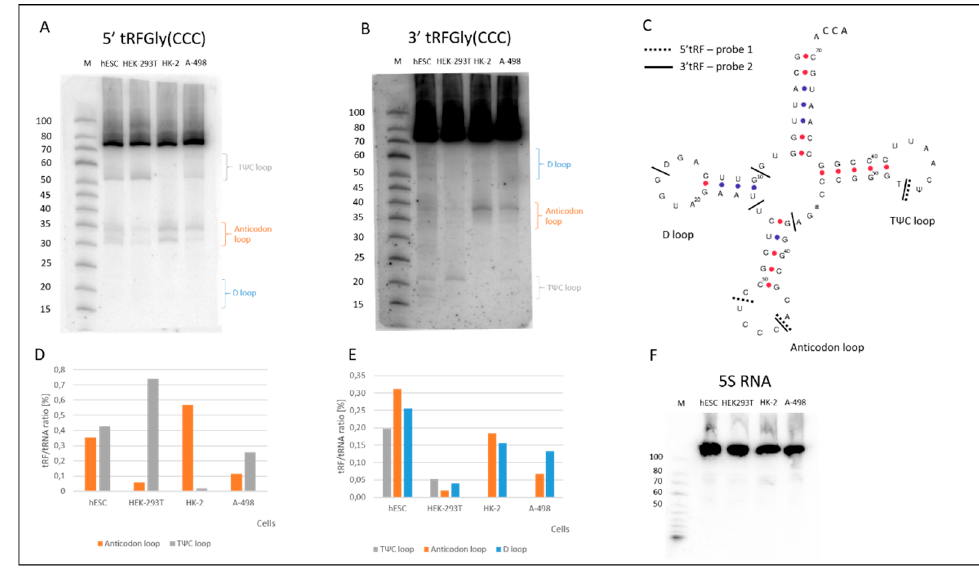
Figure 3. Characterization of the tRNAGly(CCC)-derived fragments. Northern blot ( A ) 5 ′ and ( B ) 3 ′ tRF detection with the use of two 32 P labelled probes 1 and 2 respectively (Table S1). ( C ) Secondary structure of human tRNAGly(CCC), with marked 5 ′ (---) and 3 ′ ( ꟷ ) cleavage sites. The locations of some of the modified D (dihydrouridine), T (ribothymidine) and Ψ (pseudouridine) nucleotides are marked in the tRNA structure. The loops in the tRNA structure have been named after these modifications. ( D , E ) The efficiency of the tRNAGly(CCC) cleavage in loops of the analyzed renal cells. ( F ) Loading control with a hybridization probe, which matches 5S rRNA.